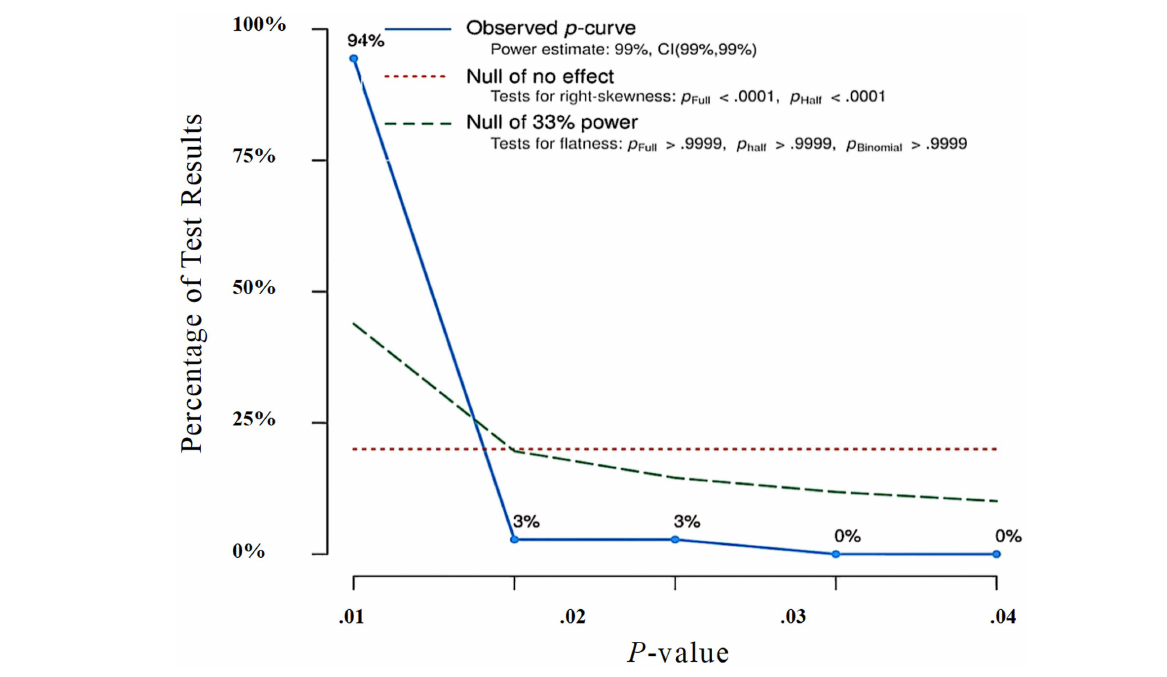
FIGURE 4 Results of the p-curve